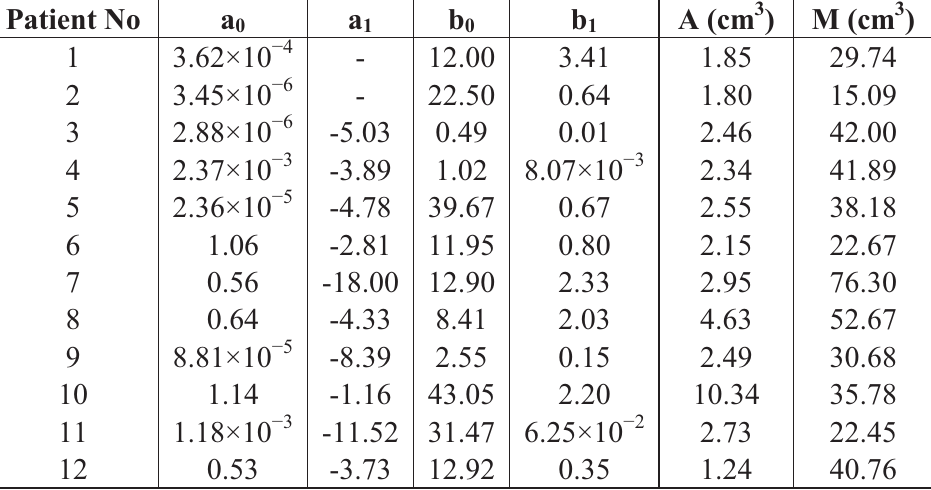
Table 2. Optimal Parameters of the Full